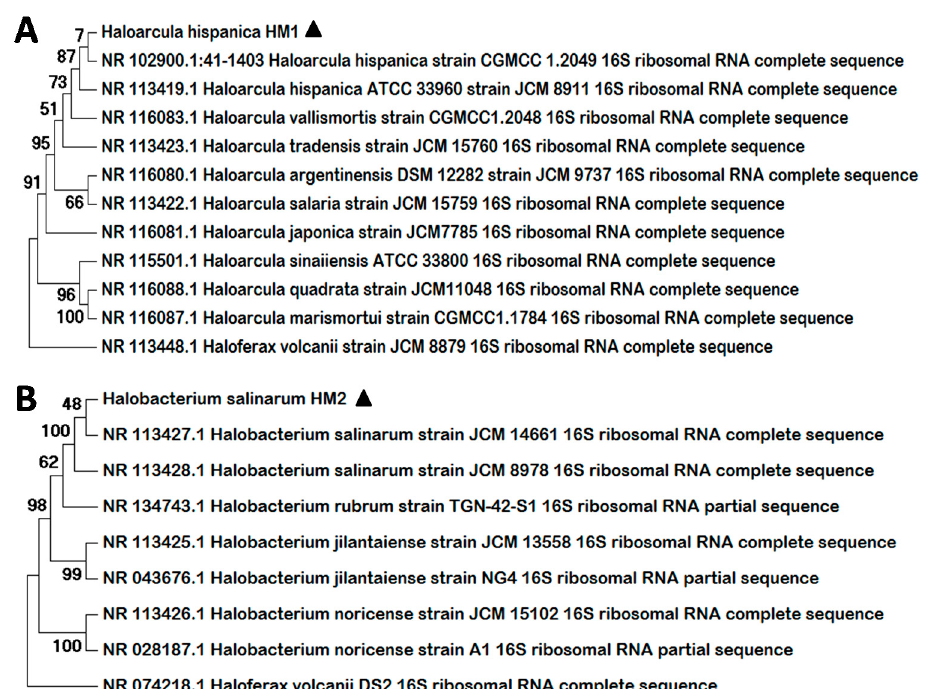
Figure 1. Molecular Phylogenetic Analysis by Maximum Likelihood Method. The trees represent a comparison among the 16S rRNA sequences from the new strains isolated, H. hispanica HM1 ( A ) and H. salinarum HM2 ( B ), and a series of reference archaeal sequences. Multiple alignments were generated by MUSCLE (MUltiple Sequence Comparison by Log-Expectation) and the trees were constructed with MEGA 7. The numbers at nodes indicate the bootstrap values calculated for 1000 replicates. The name and the NCBI access number are indicated for all the reference sequences. Black triangles indicate the new strains